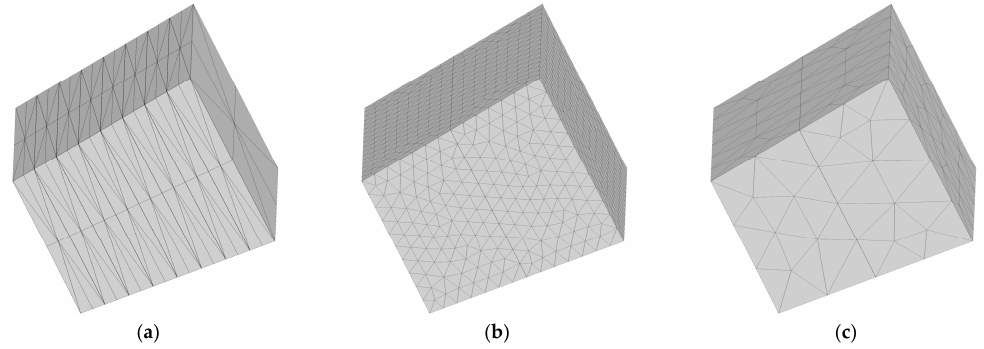
Figure 6. Meshing of: ( a ) Pulatsu’s geometry, ( b ) surface meshed geometry with mesh size of 12 mm, ( c ) surface meshed geometry with mesh size of 35 mm.